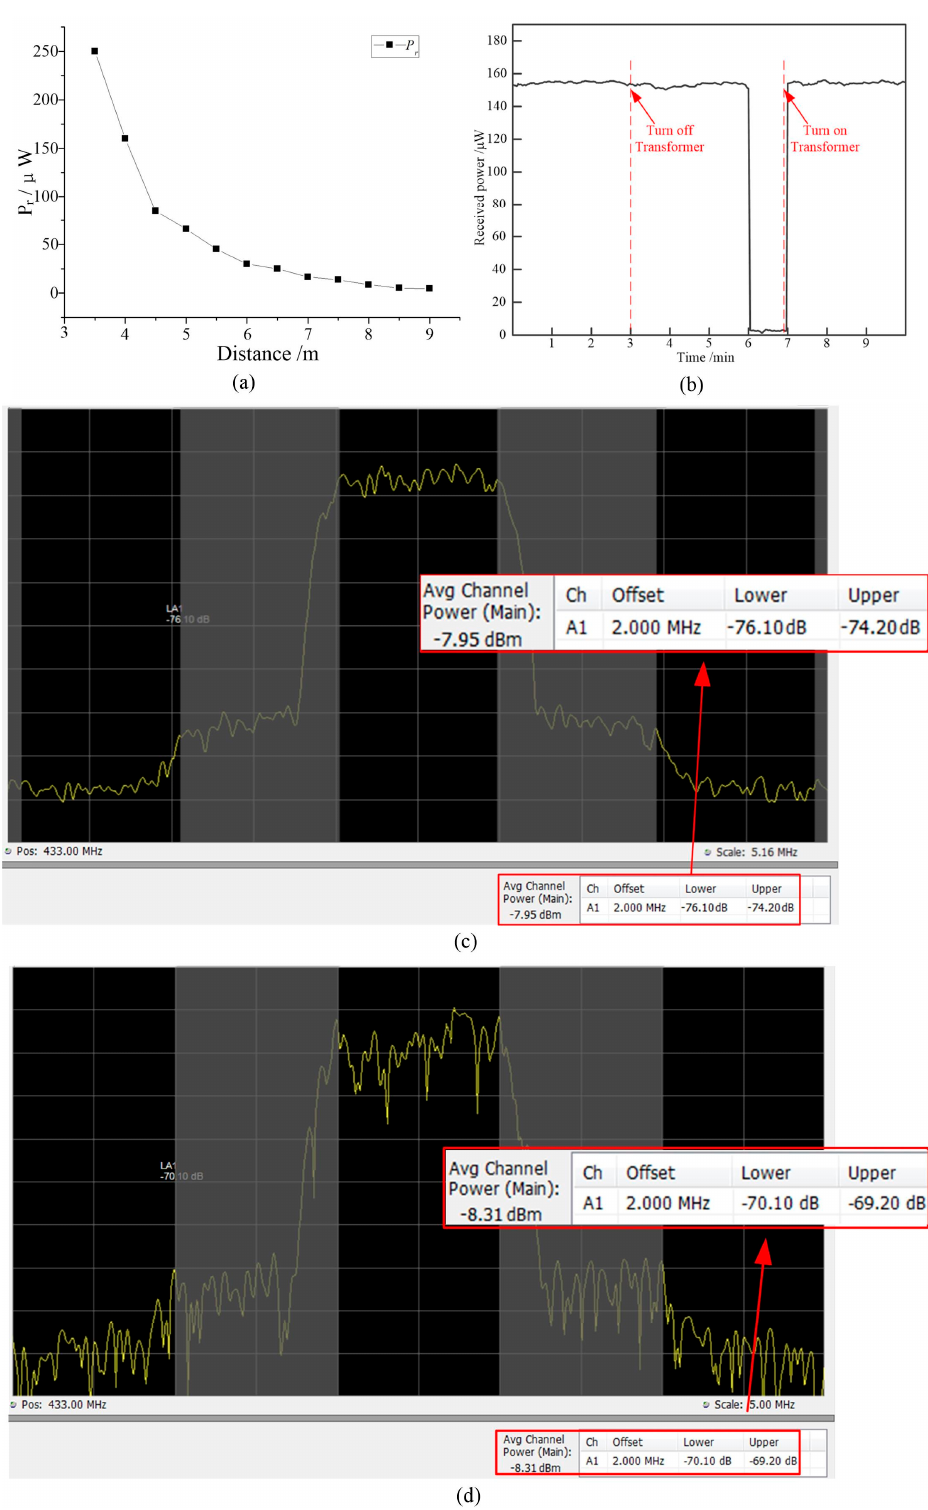
Figure 12. Results of channel power: ( a ) Measured from different distance; ( b ) Measured with influence of power outage; ( c ) Measured without noise; ( d ) Measured with noise.